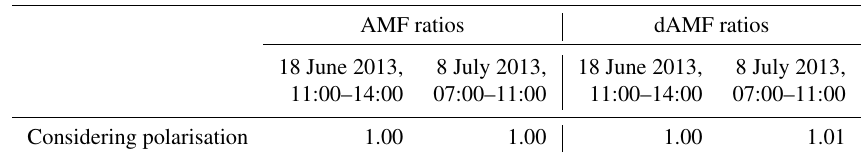
Table A12. Average ratios of O 4 (d)AMFs considering polarisation vs. those without considering polarisation for the middle period on each selected